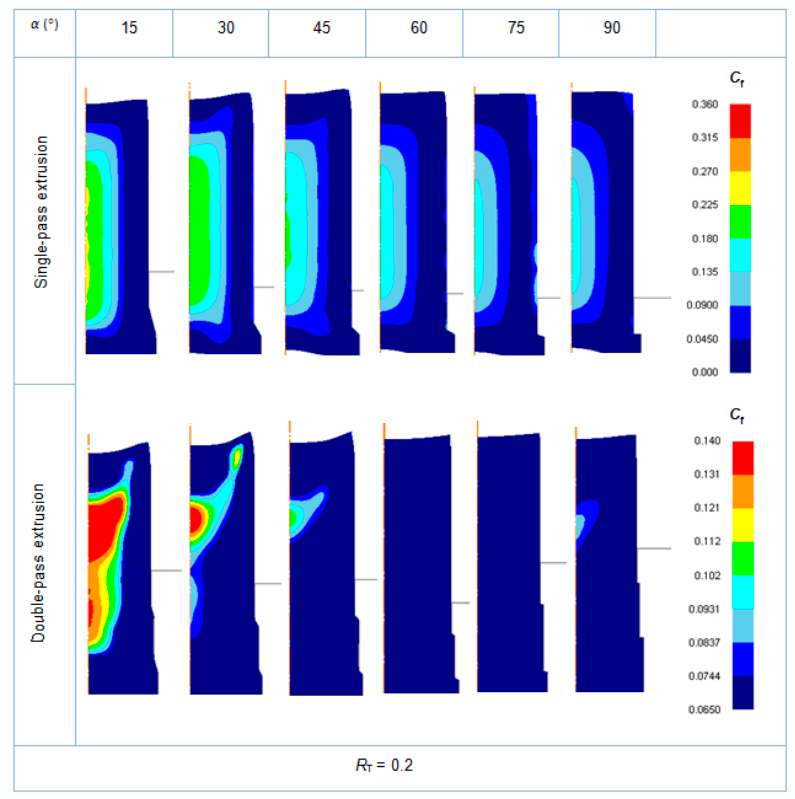
Figure 21. Comparison of damage ( C f ) induced with single-pass dies vs. the best configurations of double-pass dies with R T = 0.2.